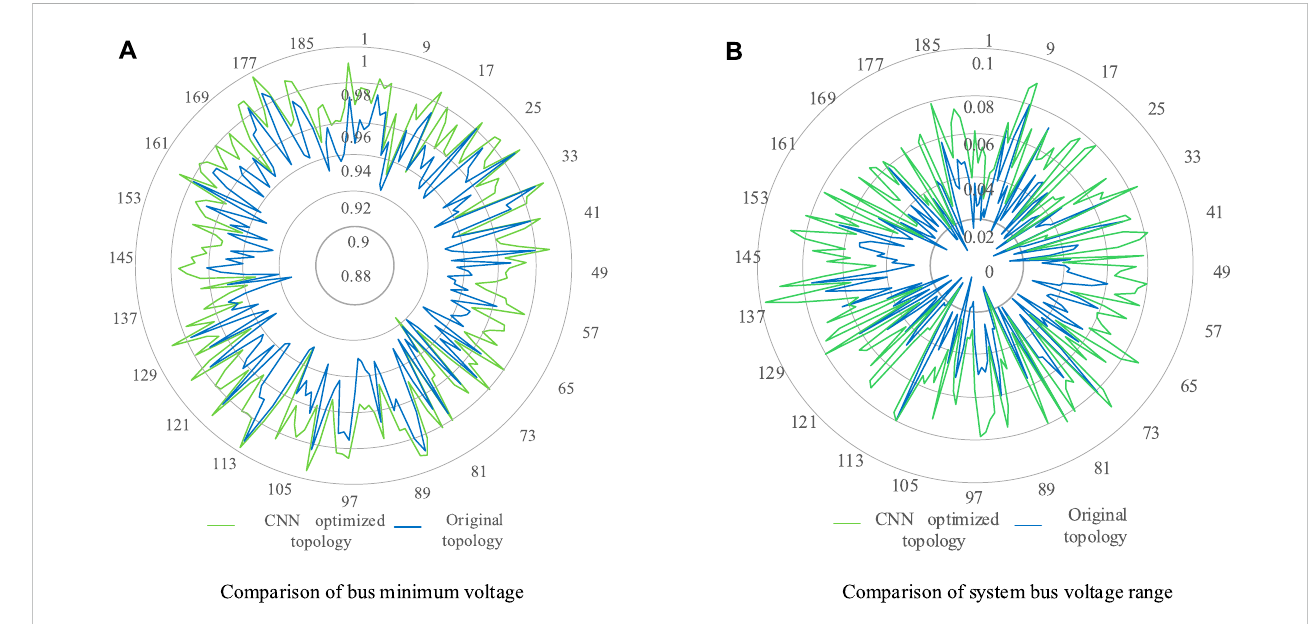
FIGURE 8 Comparison of bus voltage.